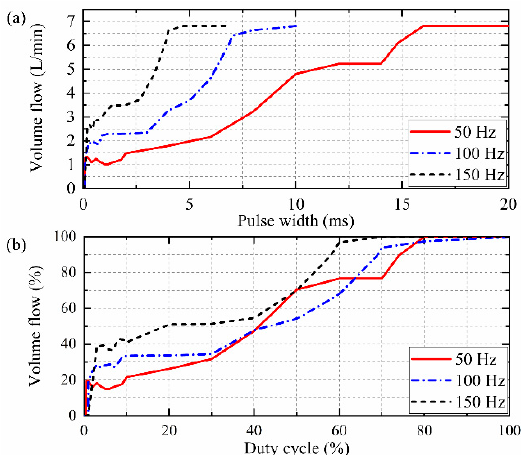
Figure 3. Standard and normalized results from 0.01 MPa pressure difference using three PWM frequencies: ( a ) Standard results; ( b ) Normalized results.